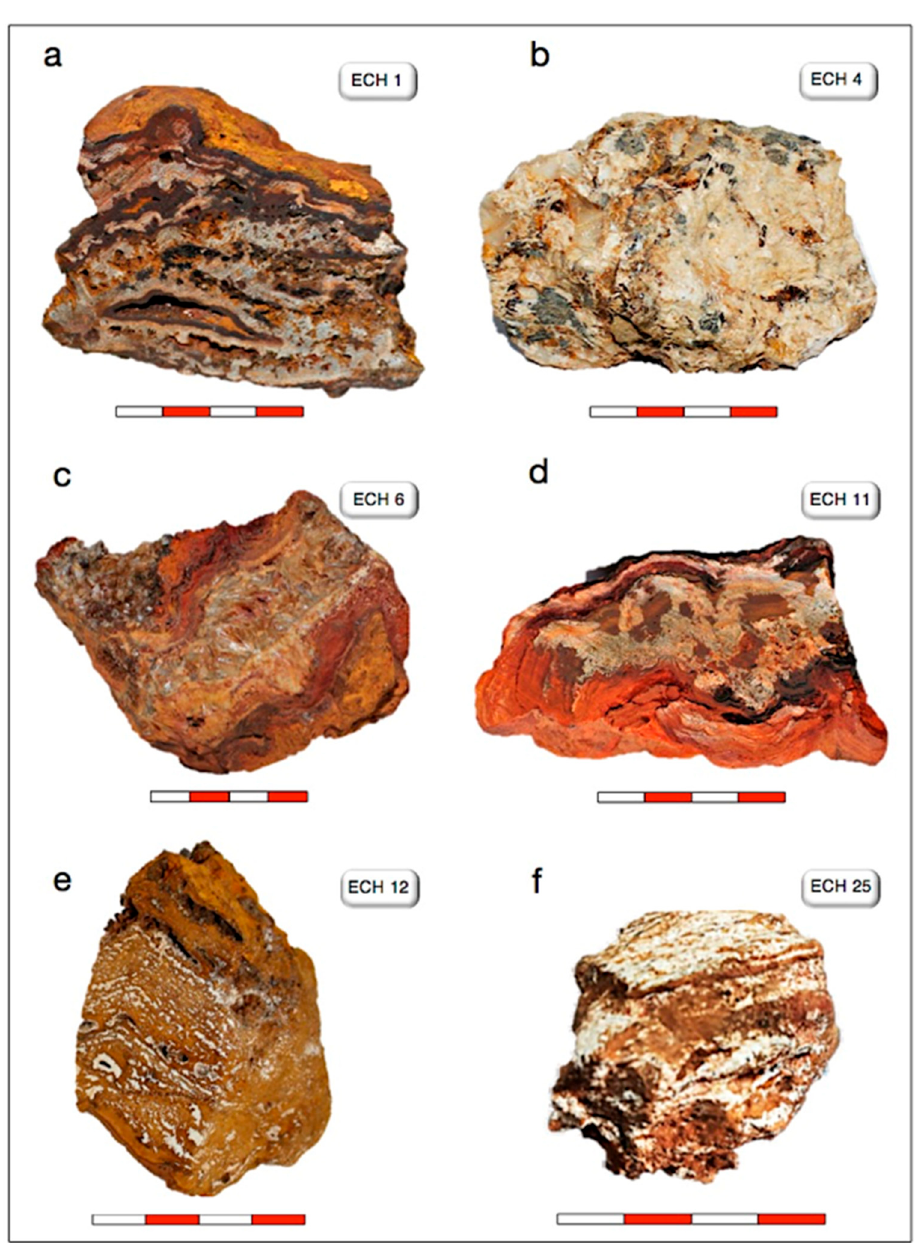
Figure 5. The typical textures of selected nonsulfide samples from the Bou Caïd area, mainly ranging from banded ( a , e , f ) to drusiform ( c , d ). A barite-galena-bearing rock from the primary mineralization is also shown in ( b ). Scale bar = 4 cm.